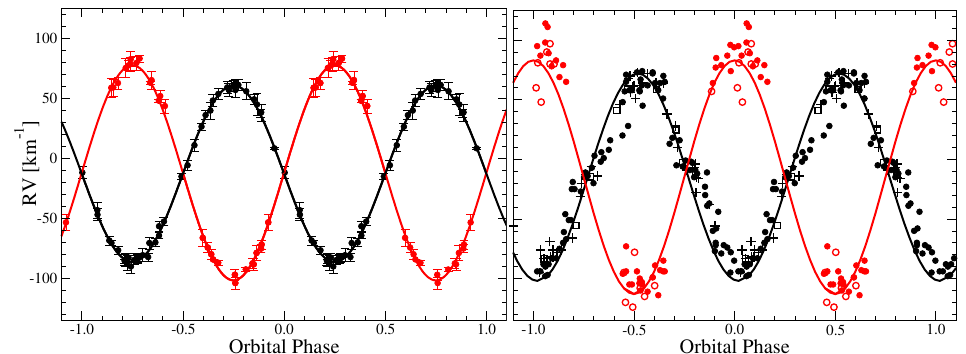
Figure 4. Left panel : RV curves of both components of 2Lac plotted using TCO data. The data for the primary component are shown by black circles, and the best fit to these data is shown by the black solid line. The data for the secondary component are shown in red, and the best fit is shown by the red solid line. The RVs are heliocentric. Right panel : RV curve of both components of 2 Lac from [10–12] with data from individual papers shown by different